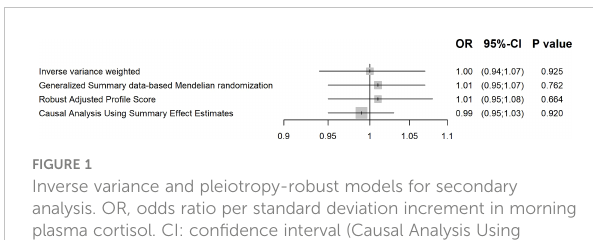
FIGURE 1 Inverse variance and pleiotropy-robust models for secondary analysis. OR, odds ratio per standard deviation increment in morning plasma cortisol. CI: con fi dence interval (Causal Analysis Using Summary Effect Estimates: Bayesian 95% credible